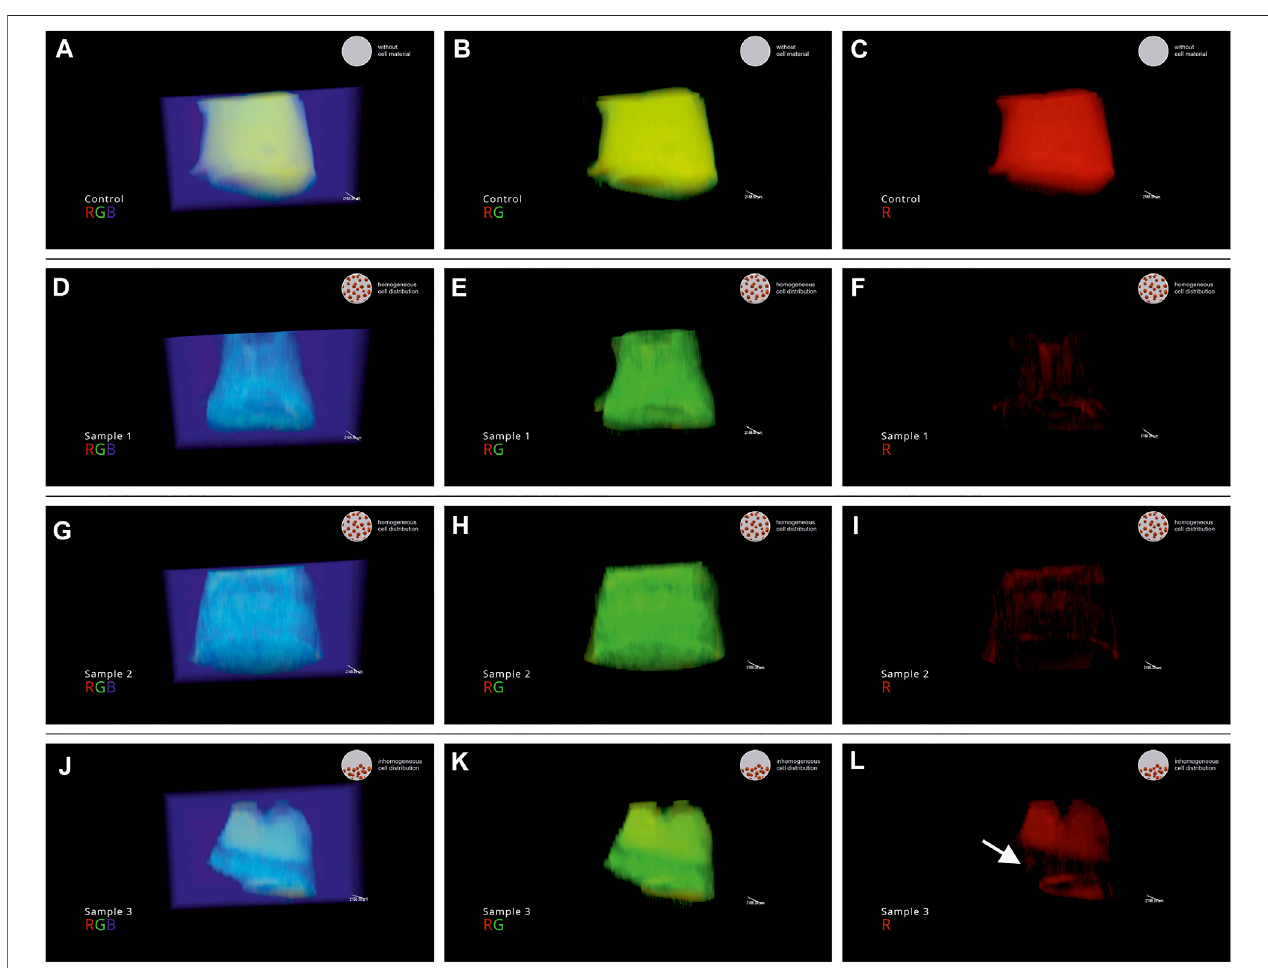
FIGURE 5 | Snap shots of the recorded VR session of the process samples of run 1. (A – C) control 1; (D – F) sample 1 (run 1) (G – I) sample 2 (run 1) (J – L) sample 3 (run 1). In the video, the channels are visualized overlaid and subsequently switched off: displayed channels left) red, green, blue (RGB); middle) red, green (RG); right) red